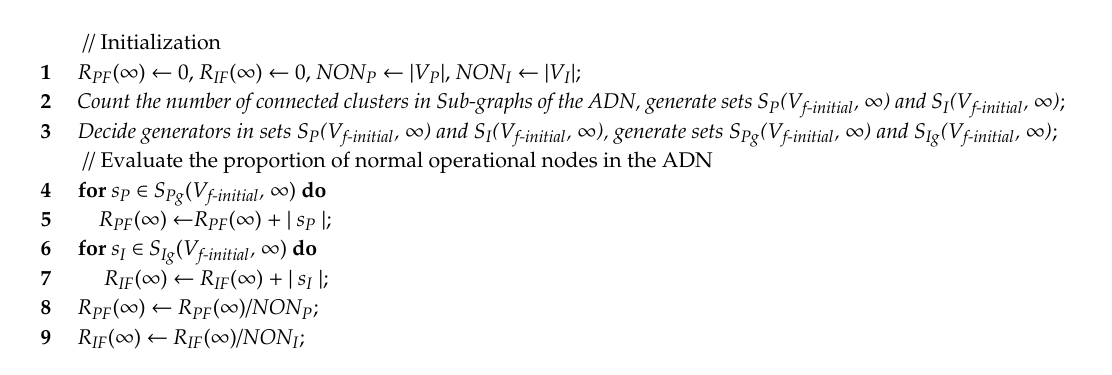
Algorithm 2 Evaluation